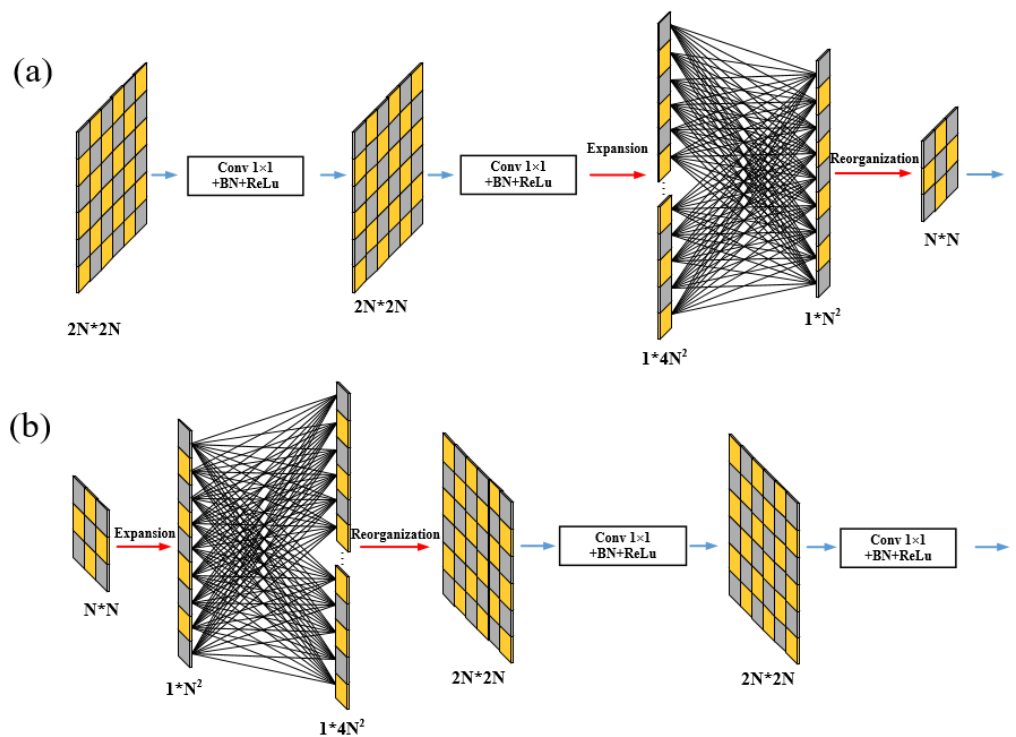
Figure 5. Sampling method: ( a ) DownSample structure; ( b ) UpSample structure.